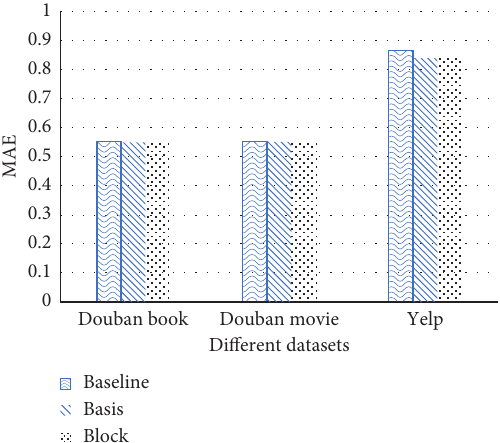
Figure 13: Normalization performance under MAE.